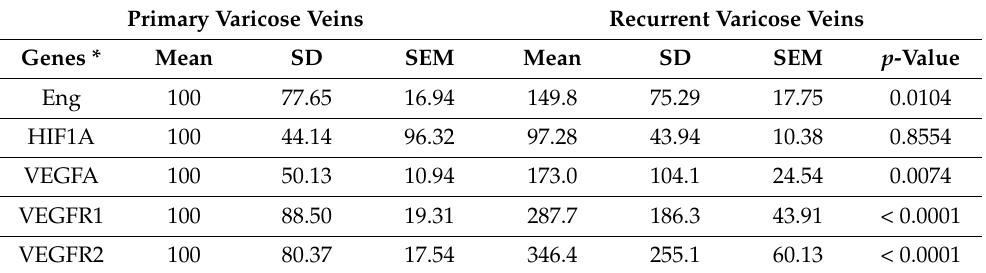
* Genes investigated: Eng, endoglin; HIF1A, hypoxia-inducible factor 1A; VEGFA, vascular endo- thelial growth factor A; VEGFR1, vascular endothelial growth factor receptor 1 (FLT1); VEGFR2, vascular endothelial growth factor receptor 2 (FLK).